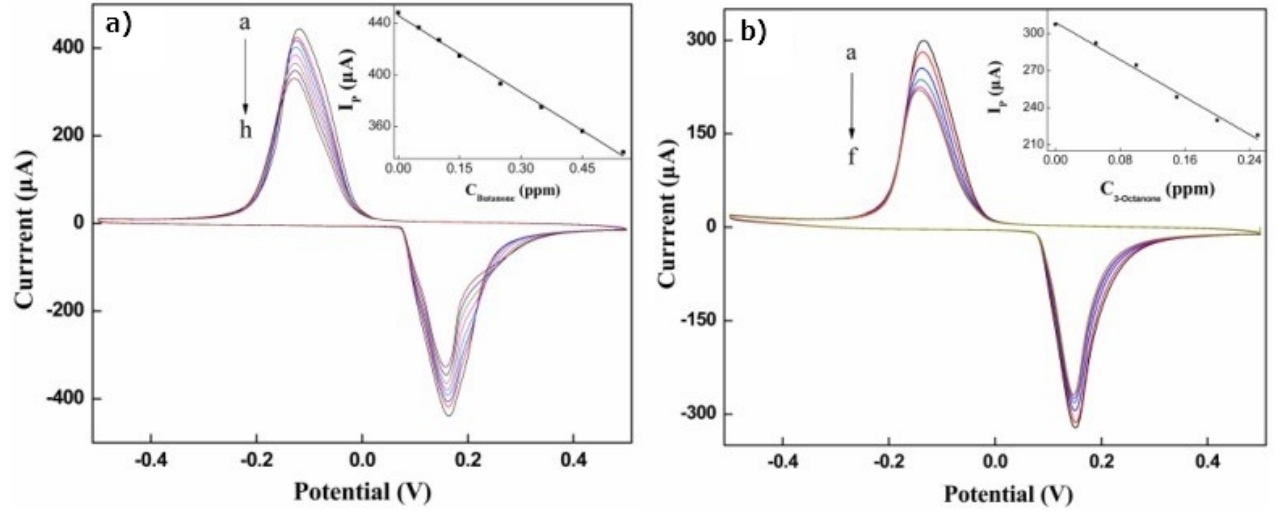
Figure 11. ( a ) The cyclic voltammograms of MWNTs/Au-Ag/GCE (butanone was varied from a to h: 0, 0.05, 0.1, 0.15, 0.25, 0.35, 0.45 and 0.55 ppm, respectively). ( b ) The cyclic voltammograms of MWNTs/Au-Ag/GCE under different concentrations of 3-octanone (varying from a to f: 0, 0.05, 0.1, 0.15, 0.2 and 0.25 ppm, respectively). The inset shows a line plot of the peak current (Ip) against the concentration of butanone and 3-octanone [206].